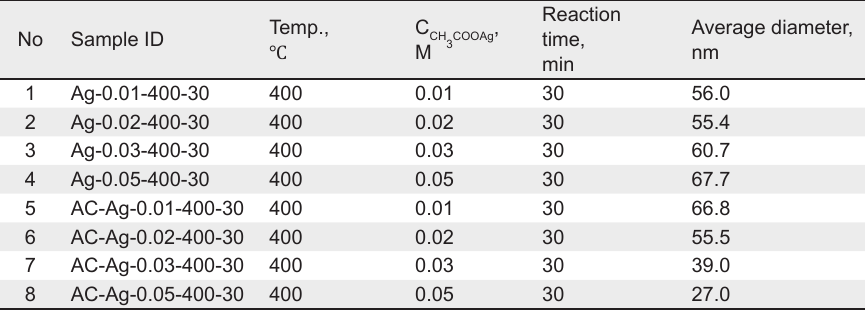
Table 1. The crystallite size of AgNPs and AC-Ag nanocomposites synthesized at 400 °C for 30 min with various precursor